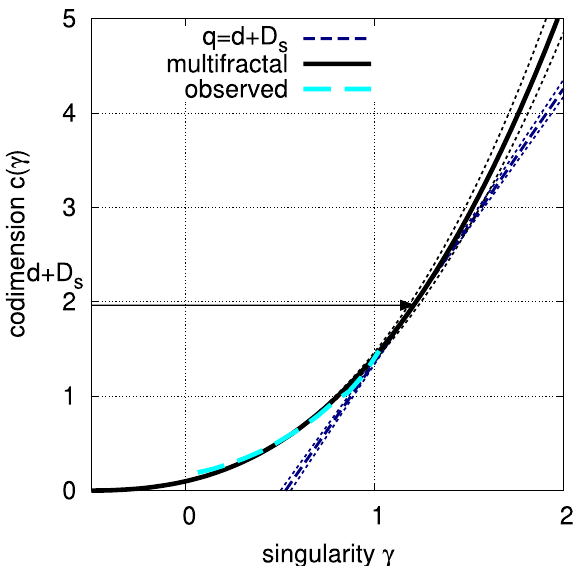
Figure 6. Codimension c (γ) of singularities γ for the best-fitting multifractal model with stable Lévy generators (black). The corresponding curve for the observational data is shown for reference (cyan). Sampling dimension D s and the limitation for the moment exponent (the slope of the navy-blue line) are also shown. Dotted lines in black and navy indicate the ranges of error due to the uncertainty in the model parameters.